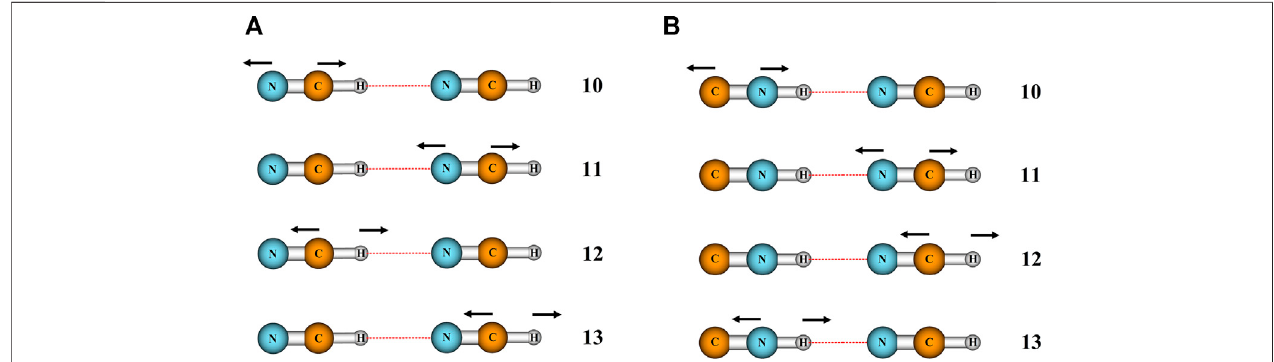
FIGURE 1 | Stretching vibrations of HCN ... HCN (A) and HCN ... HNC (B) complexes and their